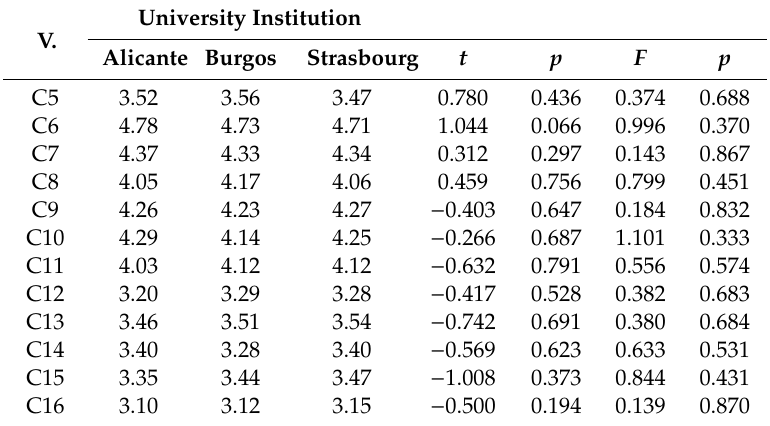
Table 5. T-test and ANOVA test according to country and university institution.